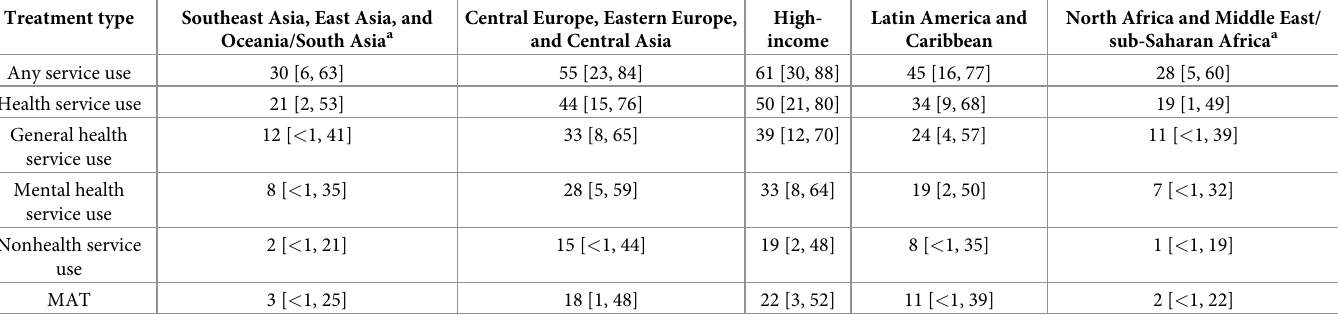
Table 6. Predicted percentage of MDD cases receiving treatment [95% UI] by GBD superregion. Treatment type Southeast Asia, East Asia, and Oceania/South Asia